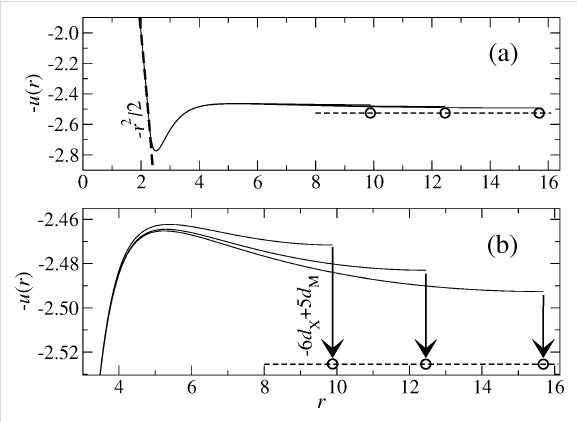
Figure 4: Negative elastic displacement − u ( r ) (as defined in Figure 1) of a tip with R = E = 1 pressed against a rigid substrate at a positive load of F N = 1.5625 for a work of adhesion Δγ = 1 and a Tabor coeffi- cient μ T = 1 resulting in an exponential decay length of z 0 = 1. In each case, the system is discretized into 512 × 512 grid points, but different sizes are used, i.e., L = L 0 , L = 2 1/3 L 0 , L = 2 2/3 L 0 with L 0 = 9.8825. Part (a) shows a larger domain including the shape of the tip in form of a dashed line. Part (b) shows a smaller domain and includes a higher- resolution estimate of the displacement at infinite radius R through the extrapolation 6 u X − 5 u M